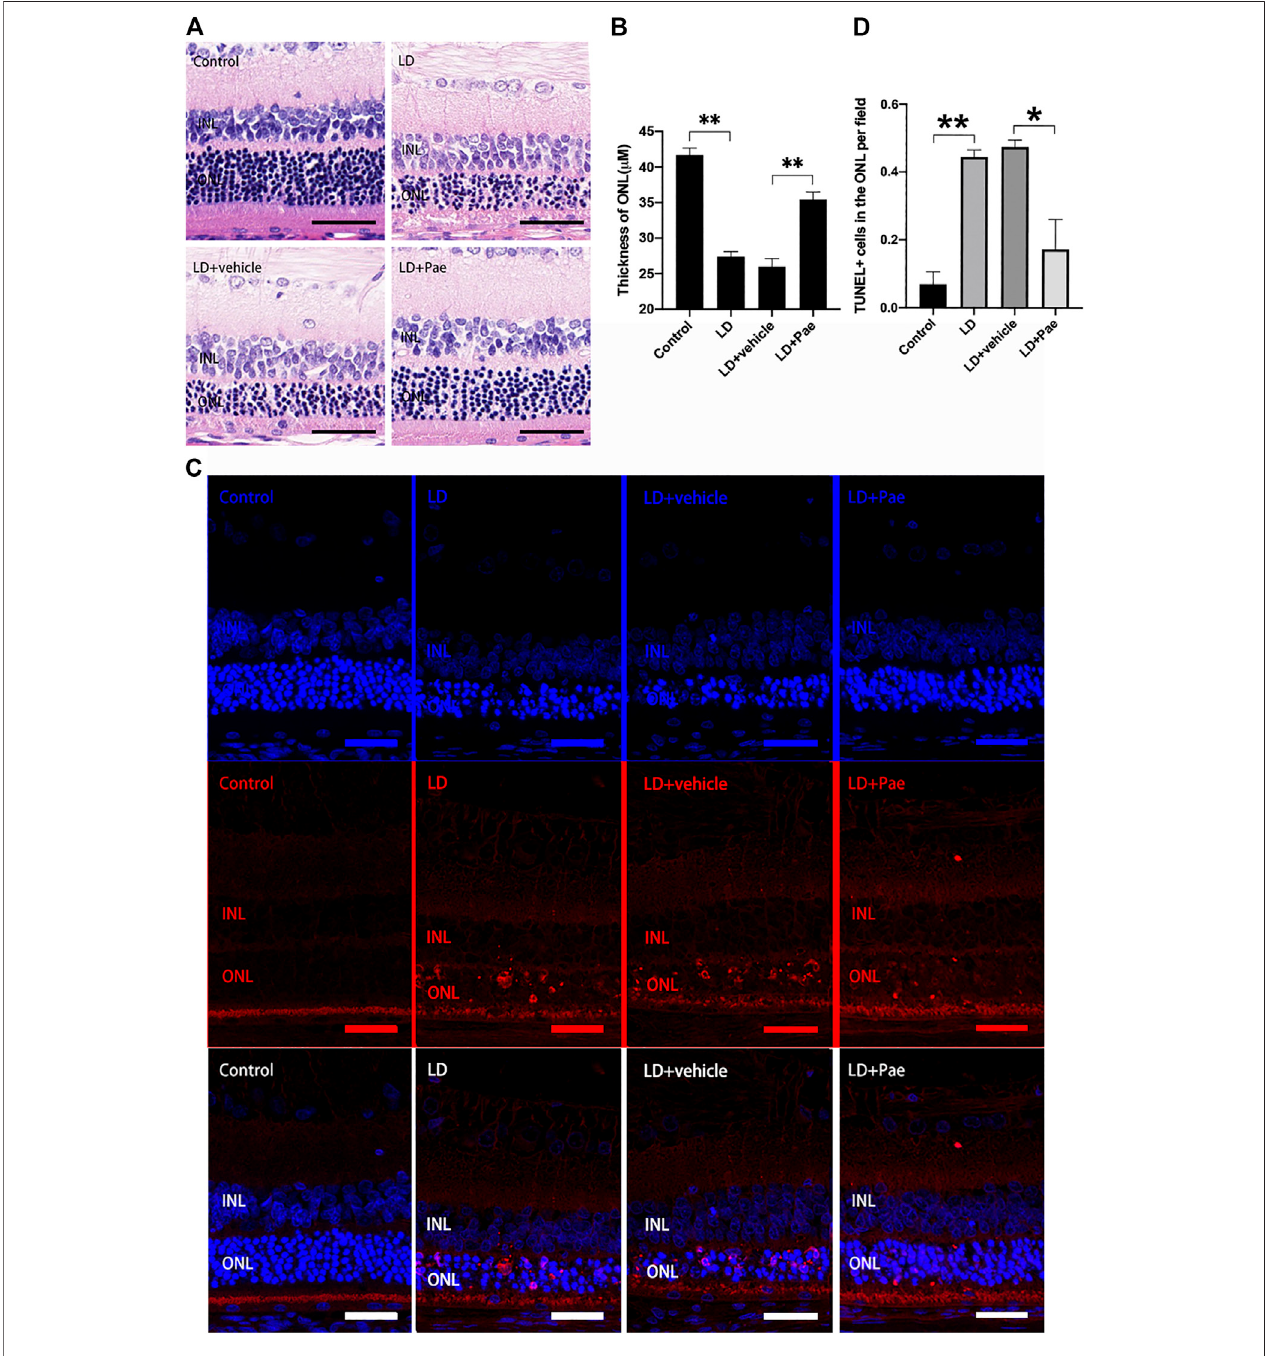
FIGURE 1 | Pae mitigated light-induced RP loss. (A) HE images of representative retinal characterized morphological changes. Light exposure caused severe degeneration on retina, particularly of the ONL. Pae can reduce the damage, representing by a clearly thicker photoreceptor layer. (B) Statistical analysis of ONL thickness of each group. (C) Representative TUNEL-stained retinal sections showed the apoptotic cells three days after light damage. Light exposure caused a rapid increase ofapoptotic cells, especiallyin theONL. LessTUNEL-positive cellswerevisibleafter Pae treatment. (D) Statistical analysisofTUNEL + cellsofeach group. Data show mean ± SD. ( n (cid:1) 6 – 8 for each group) ** p < 0.01 * p < 0.05. Scale bar: 50 μ m.